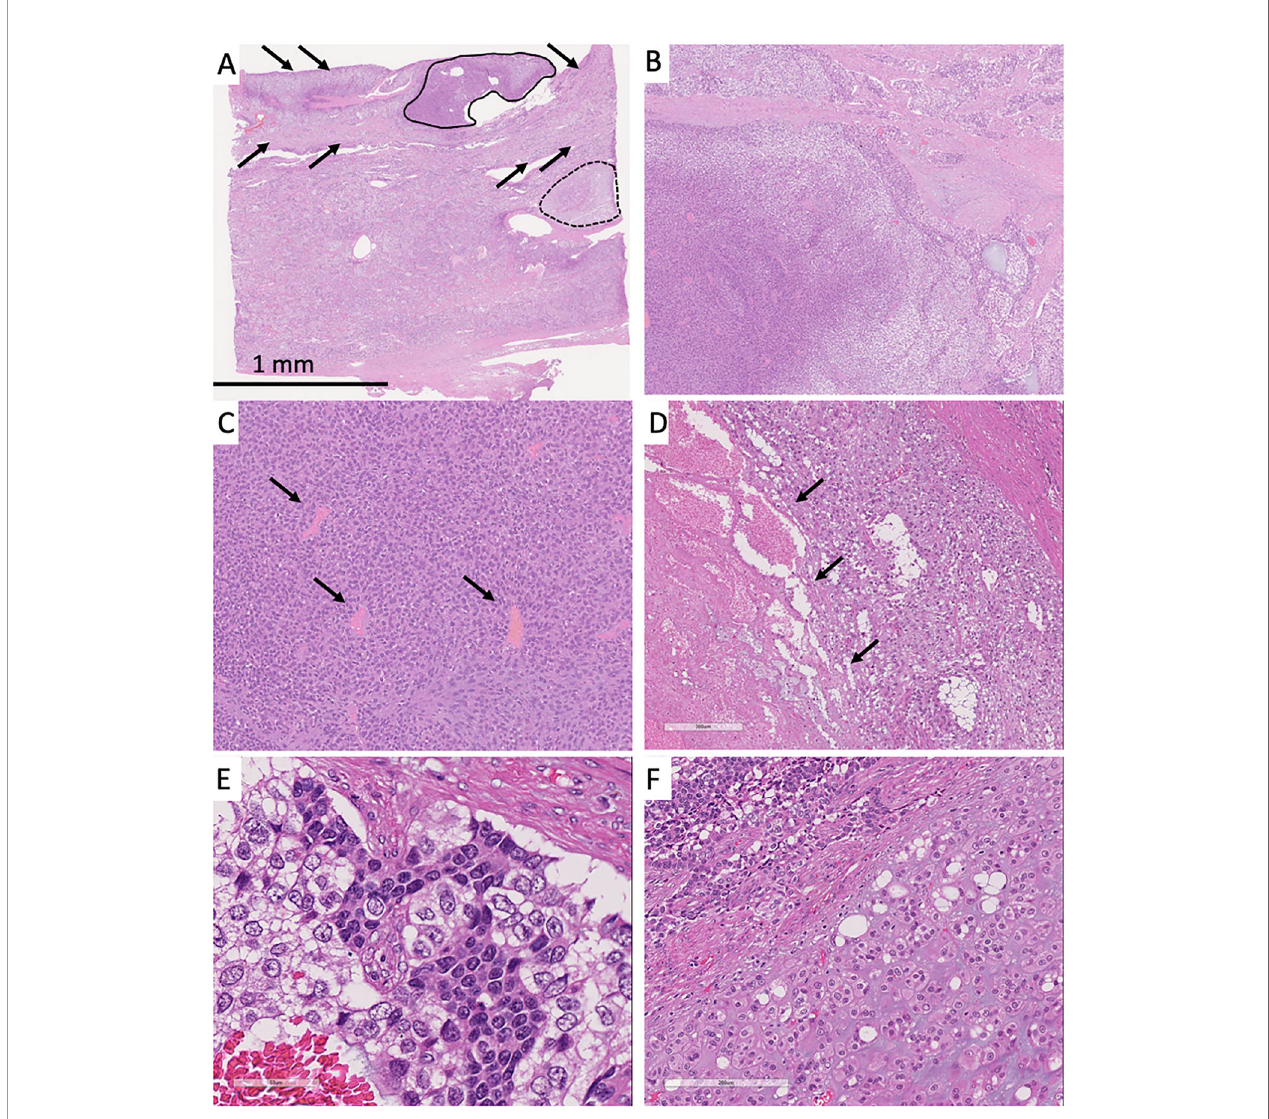
FIGURE 2 | (A) Solid tumor had the three characteristic cell components: conventional neuroendocrine tumor lesion (solid line), clear cells (arrows), and tumor cells with cartilaginous differentiation (dotted line). Most of the tumor showed mixture of the basophilic and clear cells. (B) The left part predominantly showed basophilic tumor cells and the right part clear cells. (C) Basophilic cells showed rosette patterns (arrows). (D) Clear cells showed necrosis (arrows). (E) Most of the tumor showed sheet-like appearance and mixture of basophilic and clear cells. Basophilic cells showed small round nuclei. Clear cells showed small to medium-size clear nuclei with thickened nuclear membrane. (F) The lower part showed cartilaginous differentiation, and the upper part was composed of basophilic and clear